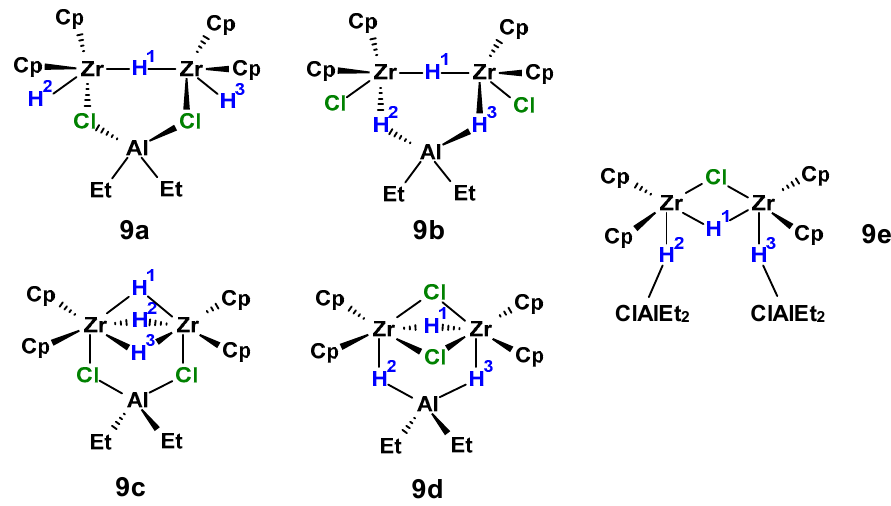
Scheme 4. Theoretically calculated structures of isomers of complex 9 . Table 4. Relative thermodynamic parameters of isomeric complexes 9.